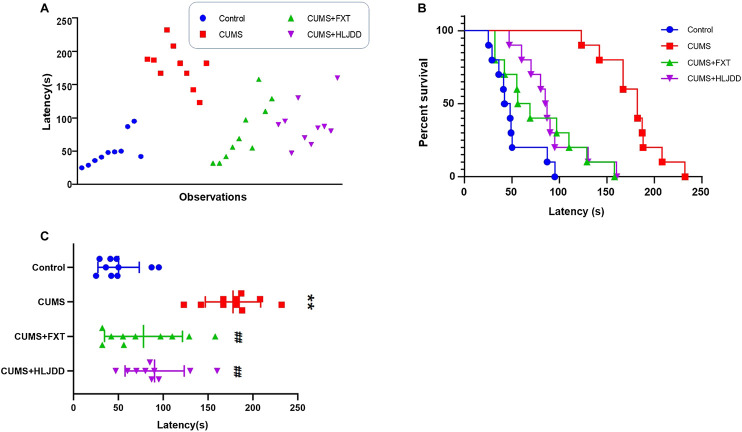
NSF results showing effect of HLJDD on behavior of CUMS mice. (A) Individual response times for consuming food of mice in the three groups (n = 10); (B) Kaplan–Meier curves of latency in mice in the three groups (n = 10); (C) Latency of approaching and consuming food of mice in the three groups 1 h after administration (n = 10, Mean ± SEM). **p < 0.01, compared with Control; ##p < 0.01, compared with CUMS via ANOVA.